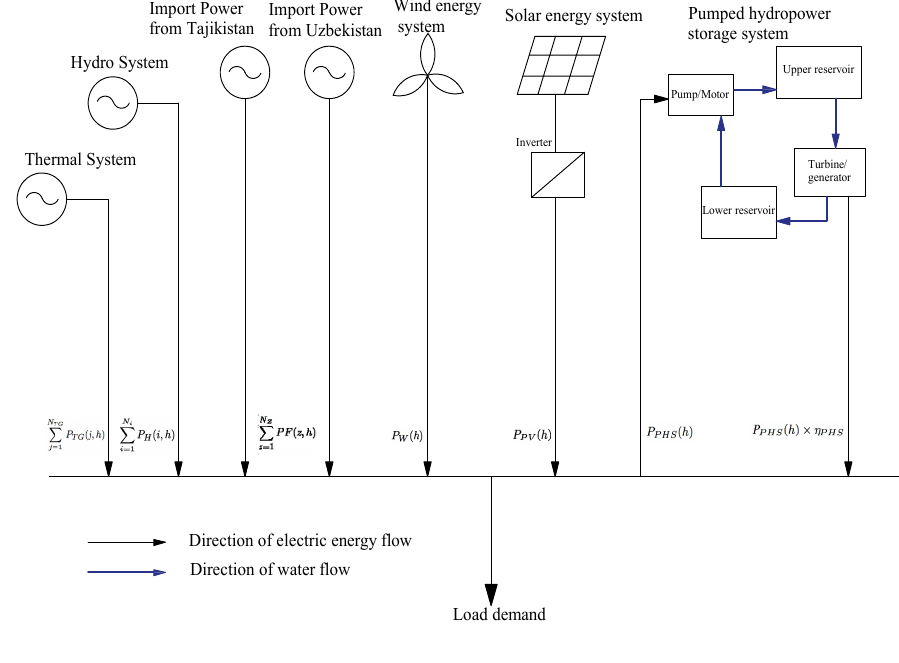
Figure 6. The generation system under study.